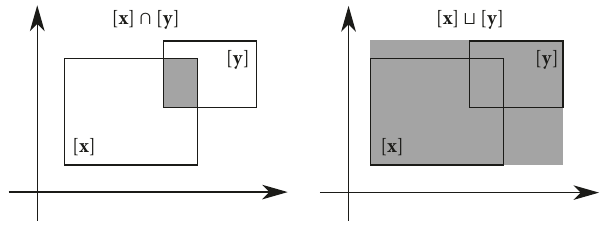
Figure 1: Intersection and interval hull of interval boxes.